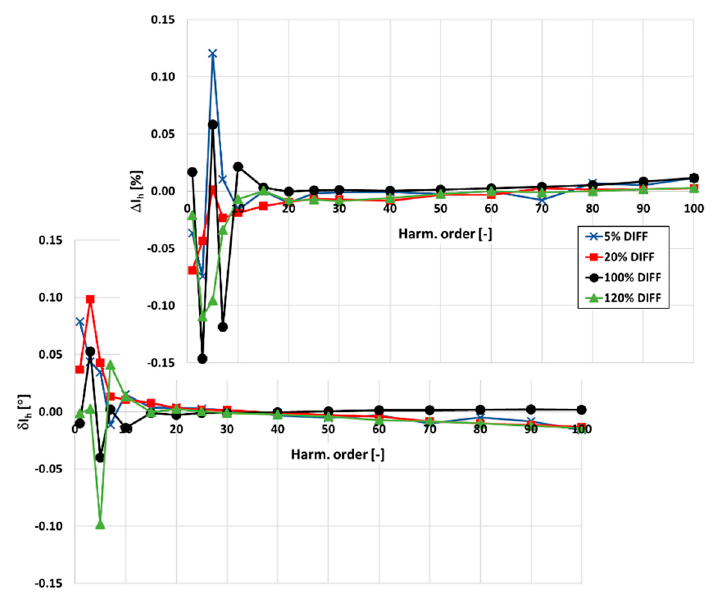
Figure 15. The differences in values of current and phase errors at harmonics determined for designed CT 300\1 A for its excitation by a single primary wire of rated current 300 A and three turns of a wire of rated current 100 A.